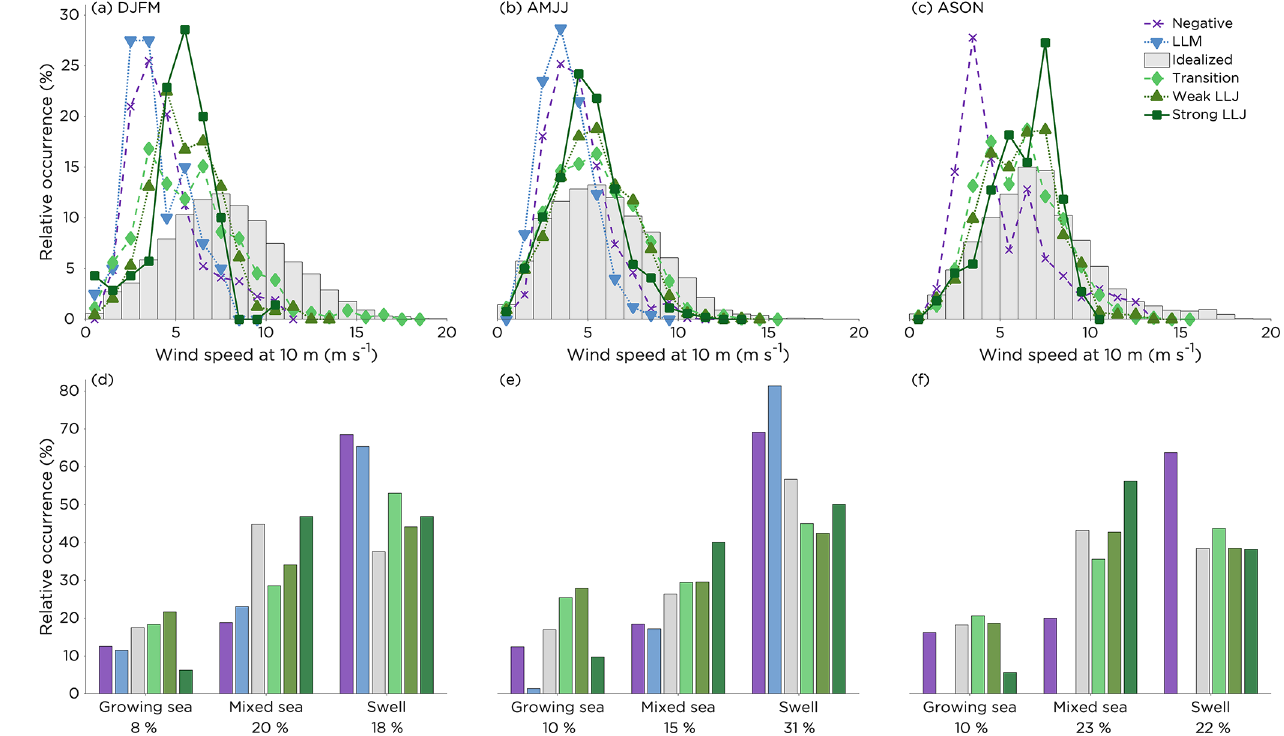
Figure 5. Seasonal distributions of (a, b, c) wind speed at 10m (all sectors) and (d, e, f) wave age classes (only open-sea sector) for non- idealized wind profiles compared to idealized profiles. The panels (a) and (d) represent DJFM; (b) and (e) represent AMJJ; and (c) and (f) represent ASON. The relative occurrences of the different wave age classes in the different seasons are also given. Note that for each season and for each type of profile the relative occurrences add up to 100% when combining the bars for the different sea states. A minimum of 20 occurrences per season was used to compile the statistics for each type of profile, and thus LLMs are not plotted in